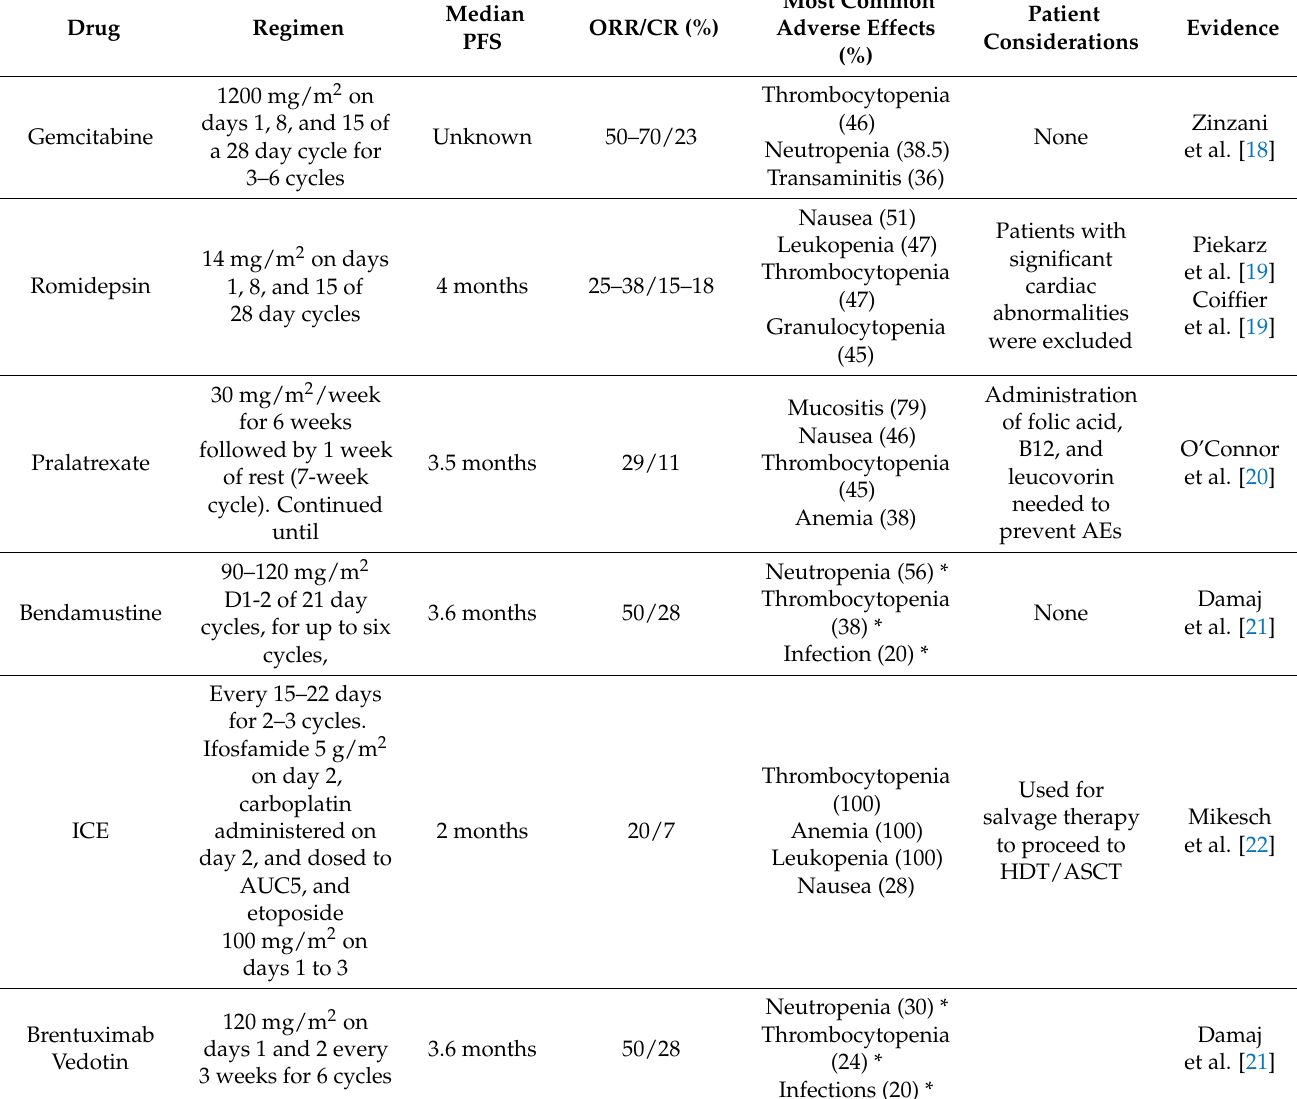
Table 2. Current Standard of